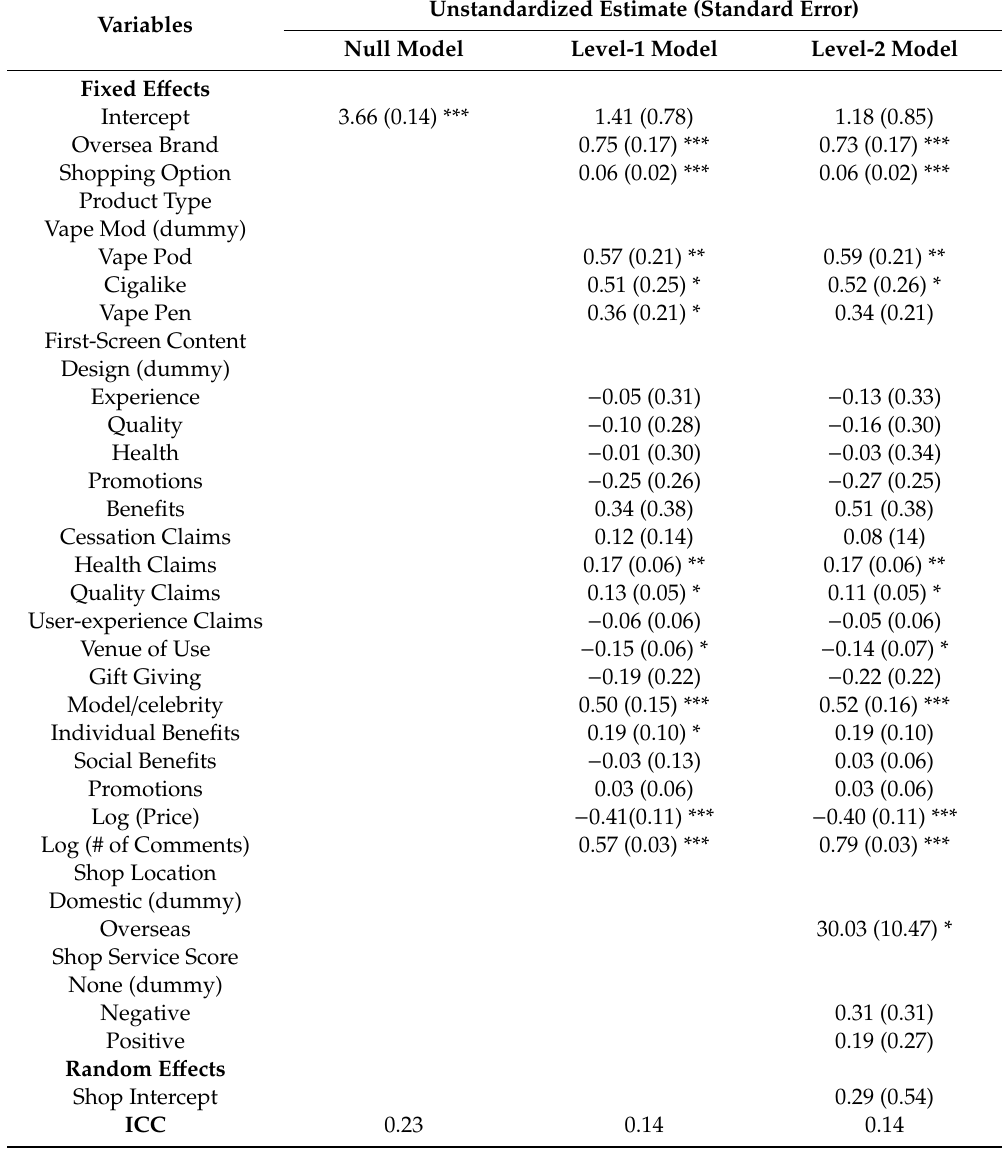
Table 3. Multilevel modeling predicting sales volume from the product, promotion, and seller